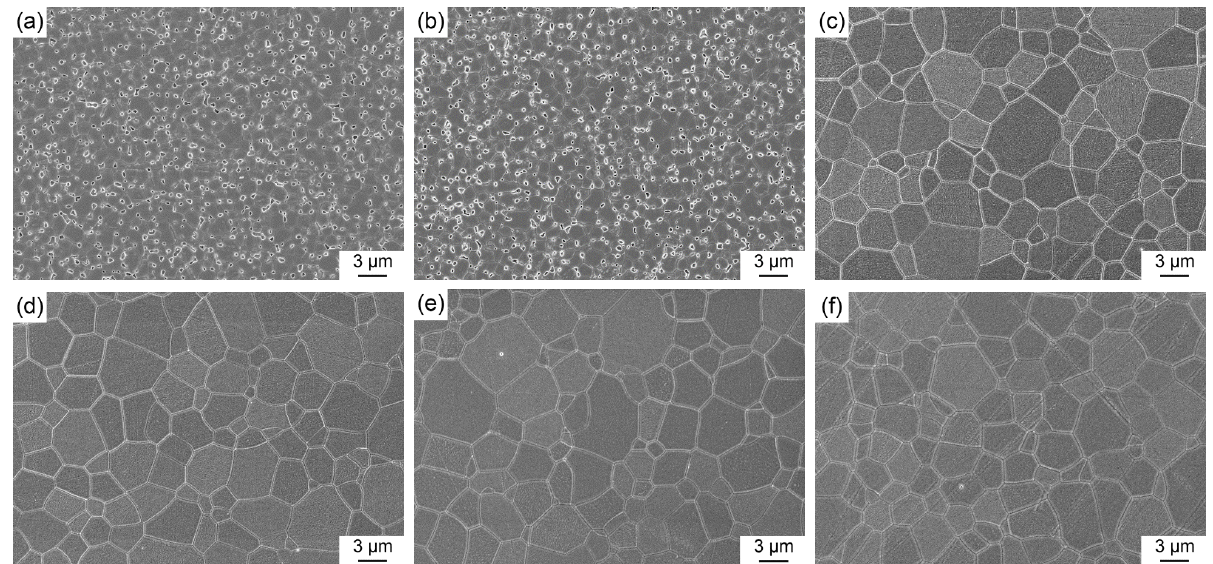
Fig. 7 FESEM micrographs of the thermally-etched surfaces of 8YSZ ceramics pre-sintered at different temperatures for 4 h in air and HIP post-treated at 1450 ℃ for 3 h under 176 MPa Ar at: (a) 1250 ℃ , (b) 1275 ℃ , (c) 1280 ℃ , (d) 1290 ℃ , (e) 1300 ℃ , and (f) 1325 ℃